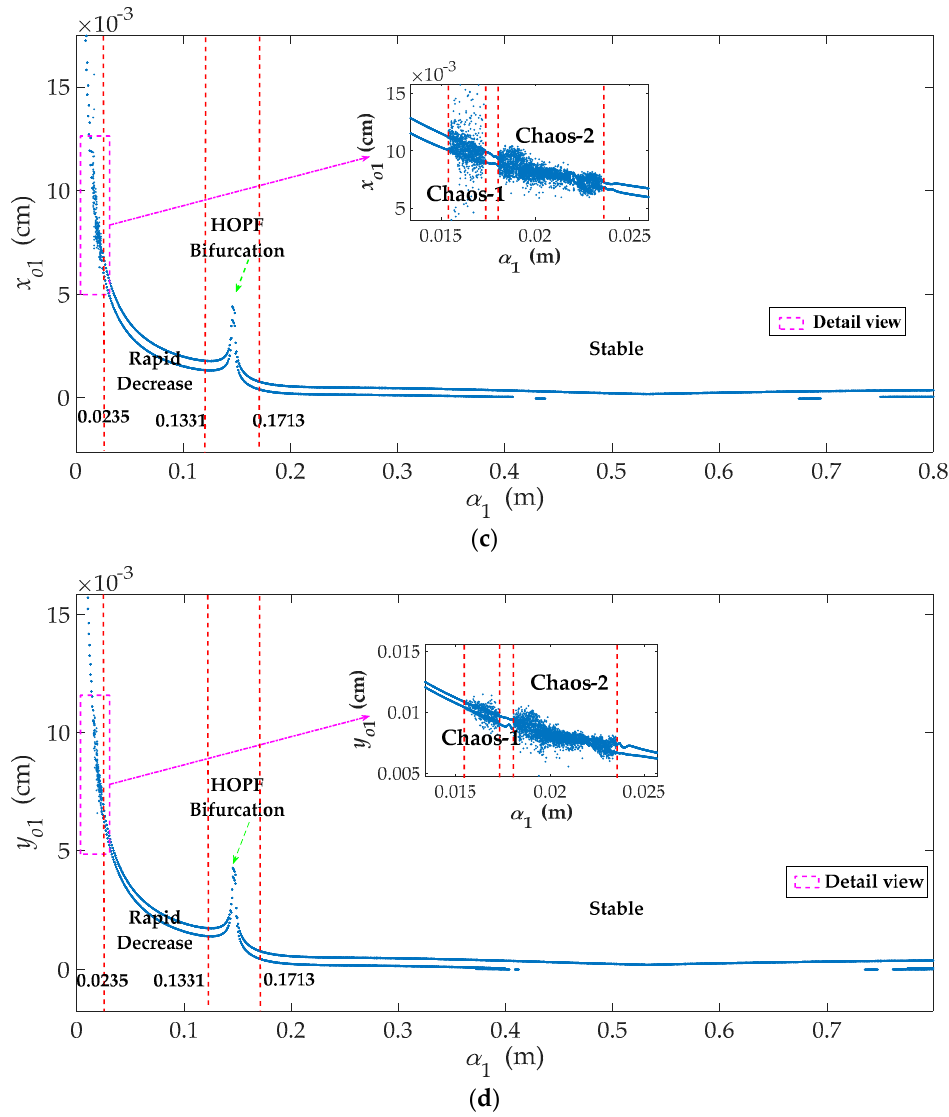
Figure 8. Bifurcation diagrams of the hydraulic unbalance forces ( P x and P y ) and the axis coordinates ( x o 1 and y o 1 ) with the guide vane opening angle ( α 1 ) increasing from 0 rad to 0.8 rad. ( a ) Hydraulic unbalance force P x ; ( b ) Hydraulic unbalance force P y ; ( c ) Axis coordinate x o 1 ; ( d ) Axis coordinate y o 1 .